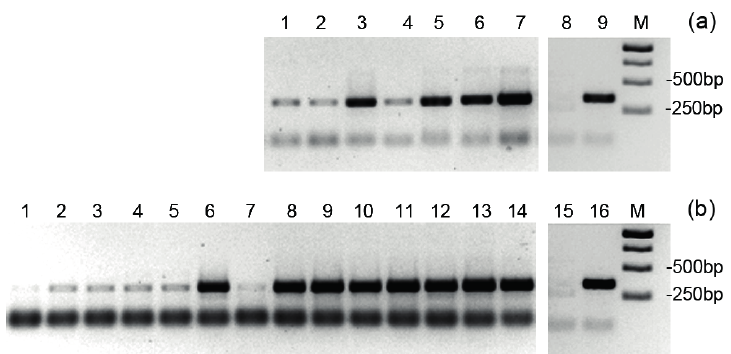
Fig. 4. Transmission of the fungus in winter barley. Rcc DNA detected by PCR in F-1, F-2, and F-3 leaves at different growth stages. (a) cv. Cinderella: 1─3. GS 83 of F-1, F-2, F-3 leaves; 4─6. GS 85 of F-1, F-2, F-3 leaves; 7. GS 87 of F-1 leaf; 8. negative control (SDW); 9. positive control (100 pg of Rcc DNA). (b) cv. Fridericus: 1‒3. GS 57‒58 of F-1, F-2, F-3 leaves; 4‒6. GS 73 of F-1, F-2, F-3 leaves; 7‒9. GS 75 of F-1, F-2, F-3 leaves; 10‒12. GS 83 of F-1, F-2, F-3 leaves; 13‒14. GS 85 of F-1, F-2 leaves; 15. negative control (SDW);